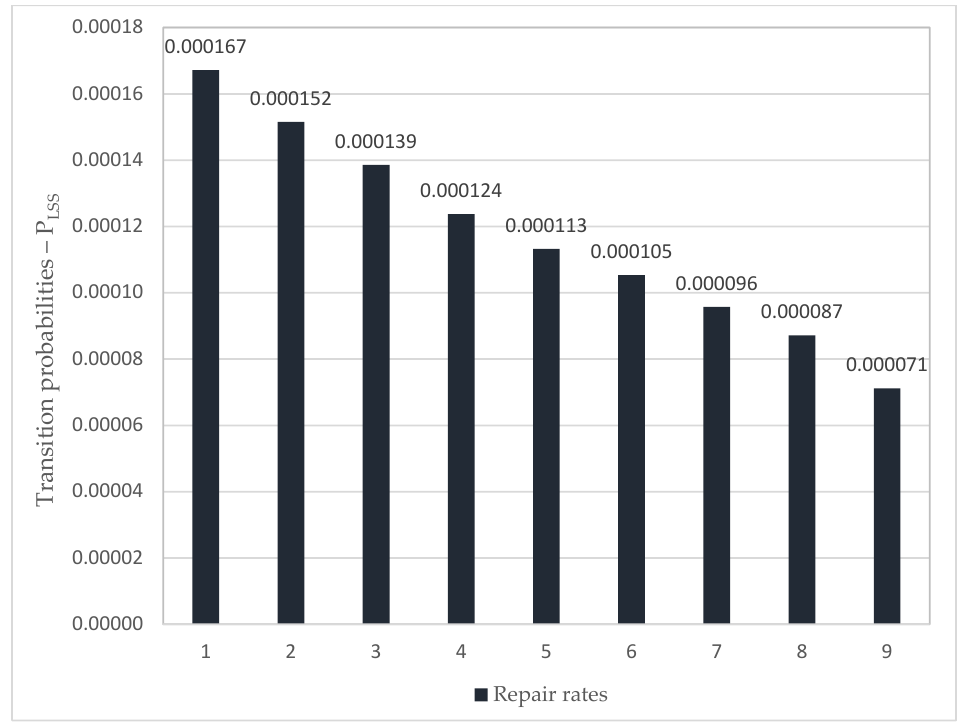
Figure 9. Dependence of the P LSS values on the repair rates µ TSS and µ LSS acc. to Figure 6, for constant failure rates: λ CSS = 0.0028379 d −1 , λ TSS = 0.0007703 d −1 , and λ LSS = 0.0000220 d −1 .